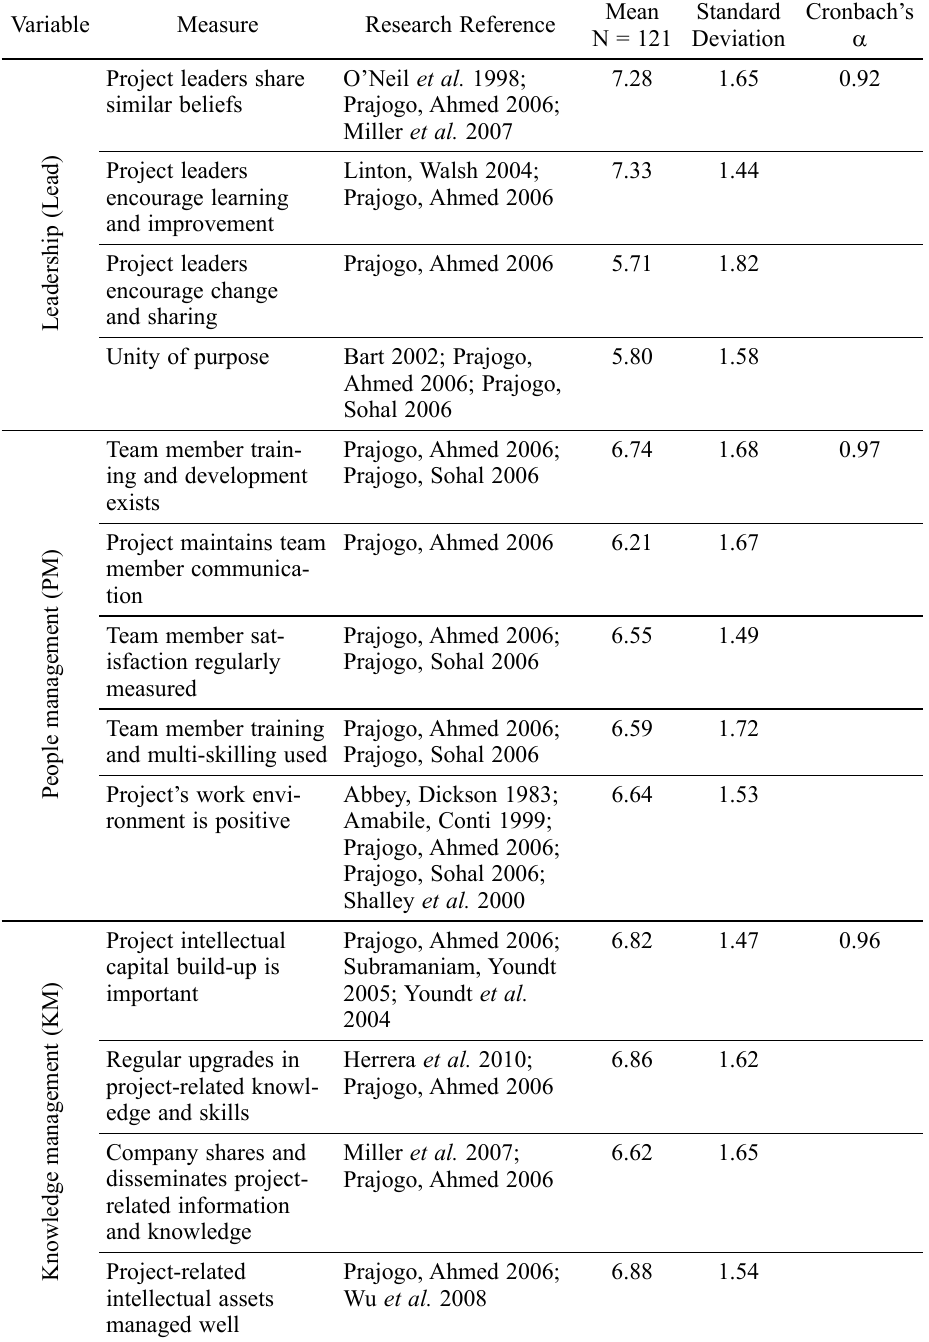
Table 1. Taxonomy, means, standard deviations, and